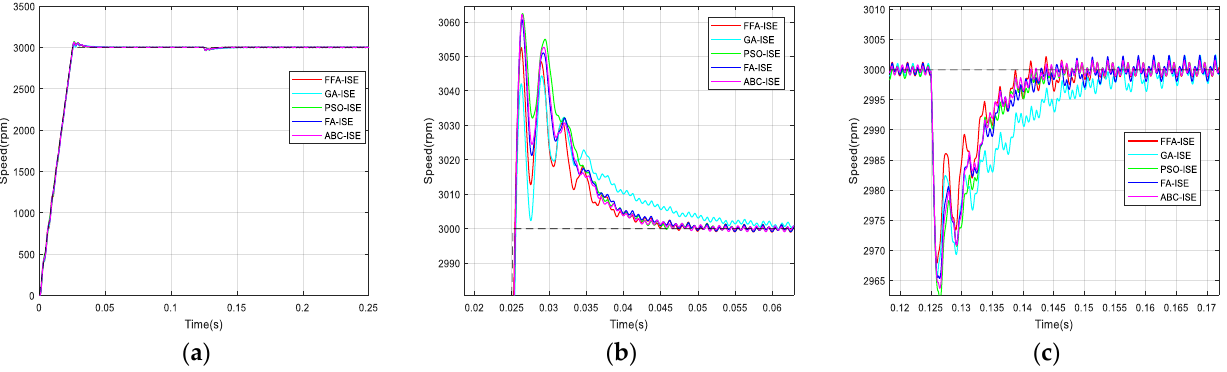
Figure 13. Comparison of speed responses with different algorithms using ISE criterion: ( a ) original; ( b ) and ( c ) zoomed version.